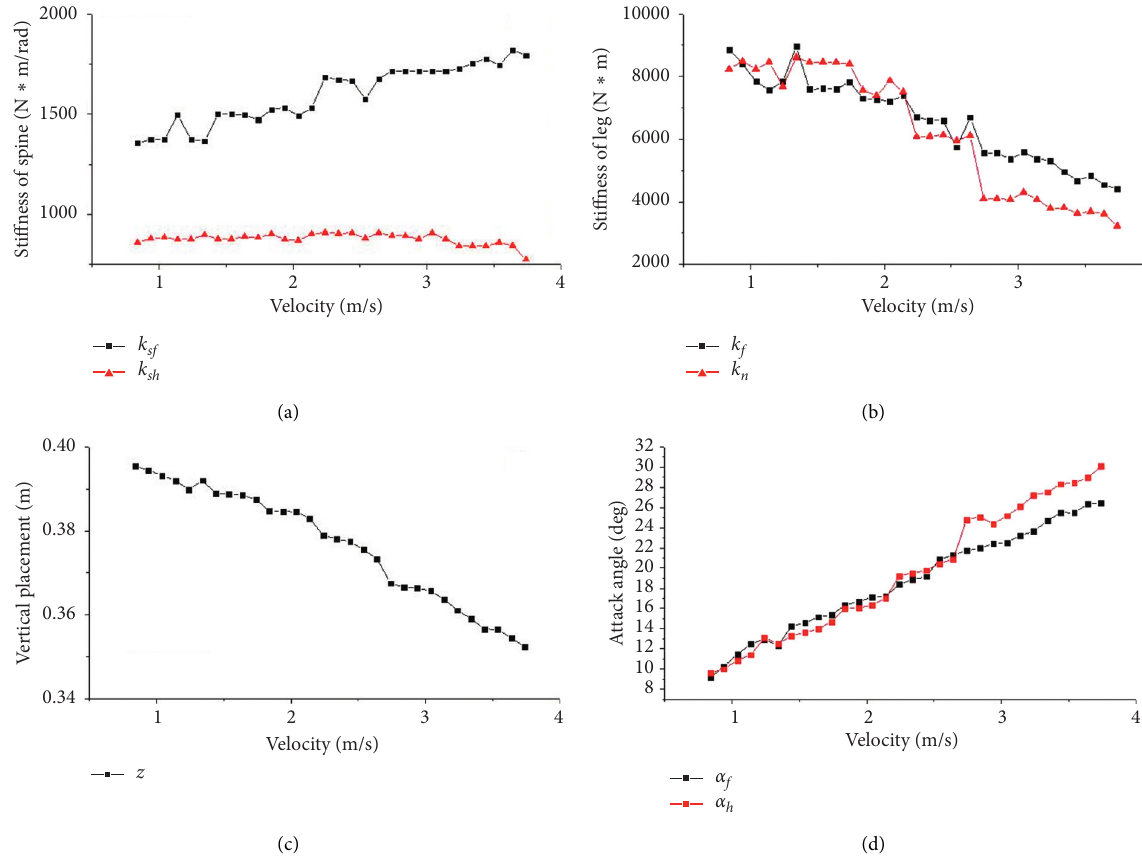
Figure 7: Dynamics characteristics at different velocities. (a) Stiffness of front and hind spinal joint, (b) stiffness of forelimb and hindlimb, (c) initial vertical displacement of the middle body, and (d) attack angle of forelimb and